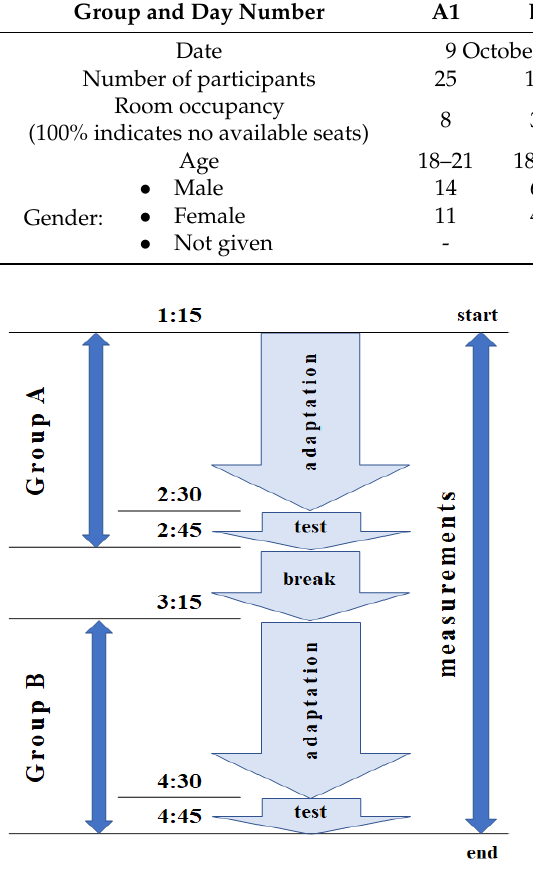
Figure 2. The experiment and measurement procedure.